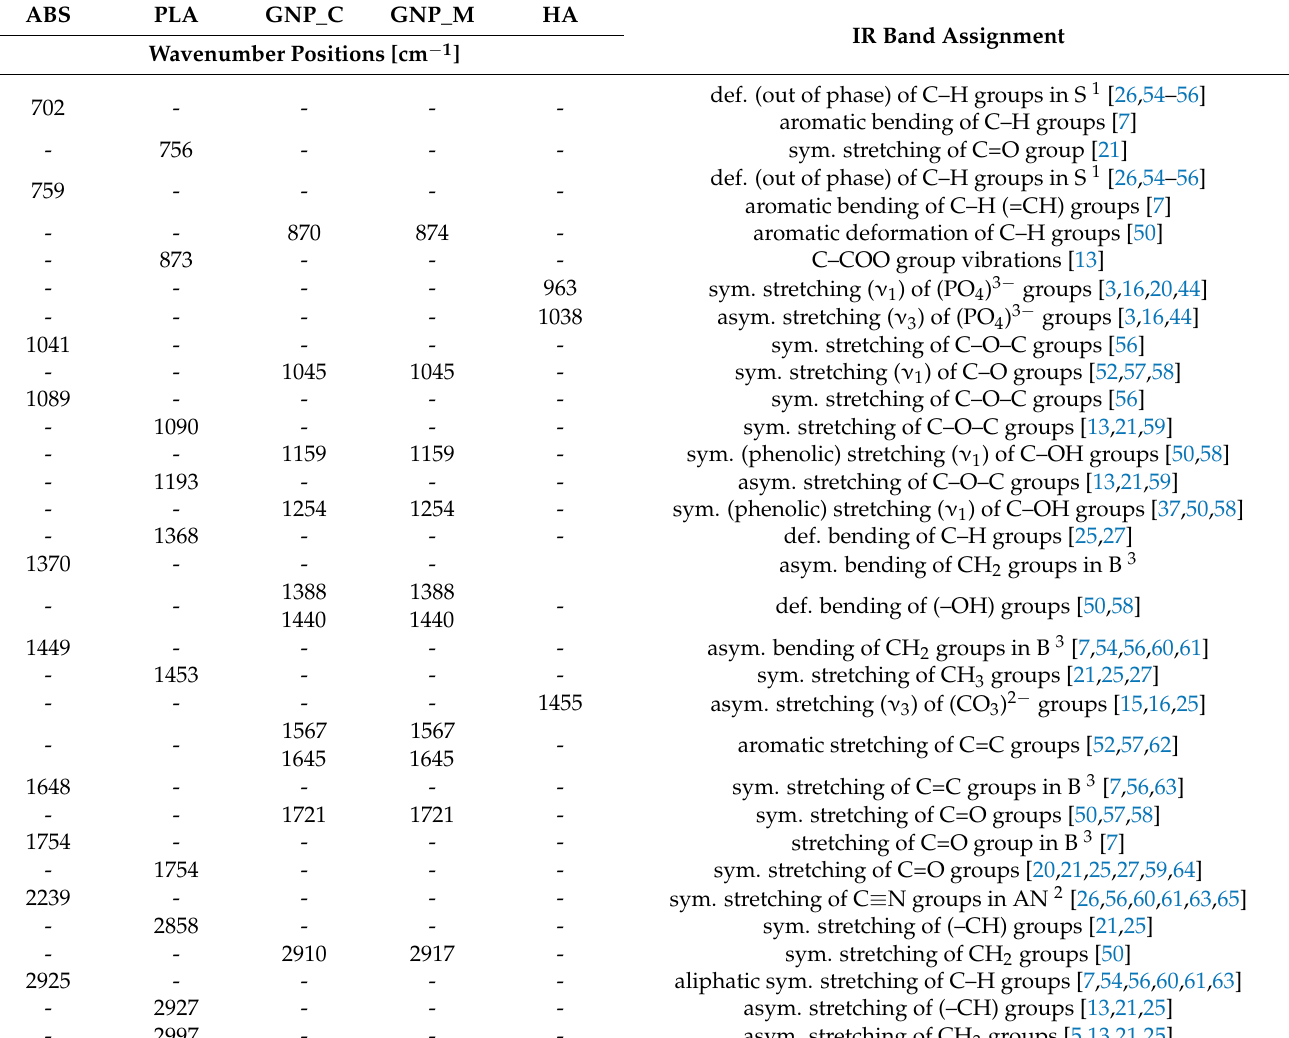
Table 1. IR band assignment for prime and reinforcement precursor materials.